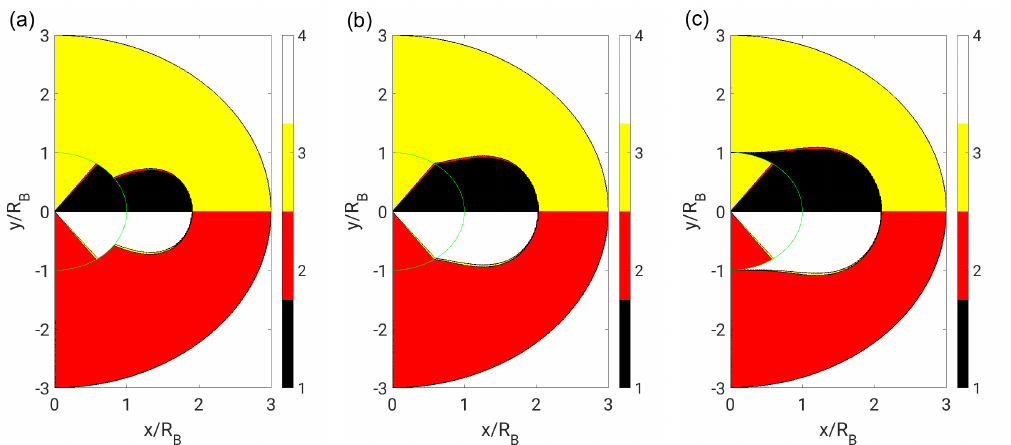
Figure 12. Flow topologies for: ( a ) very small ( ξ = 10 − 5 ); ( b ) identical ( ξ = 1); and ( c ) very large